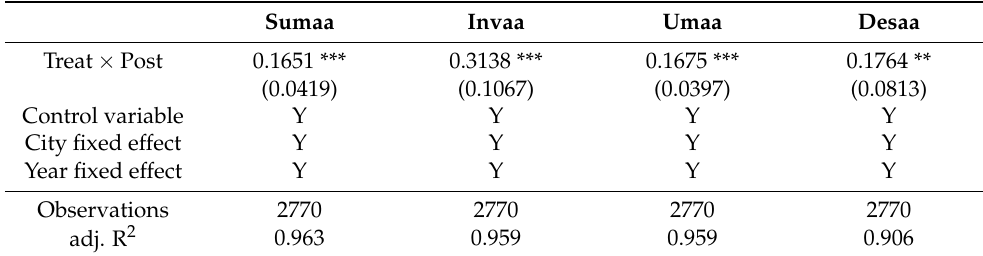
Table 7. Regression results of eliminating interference.